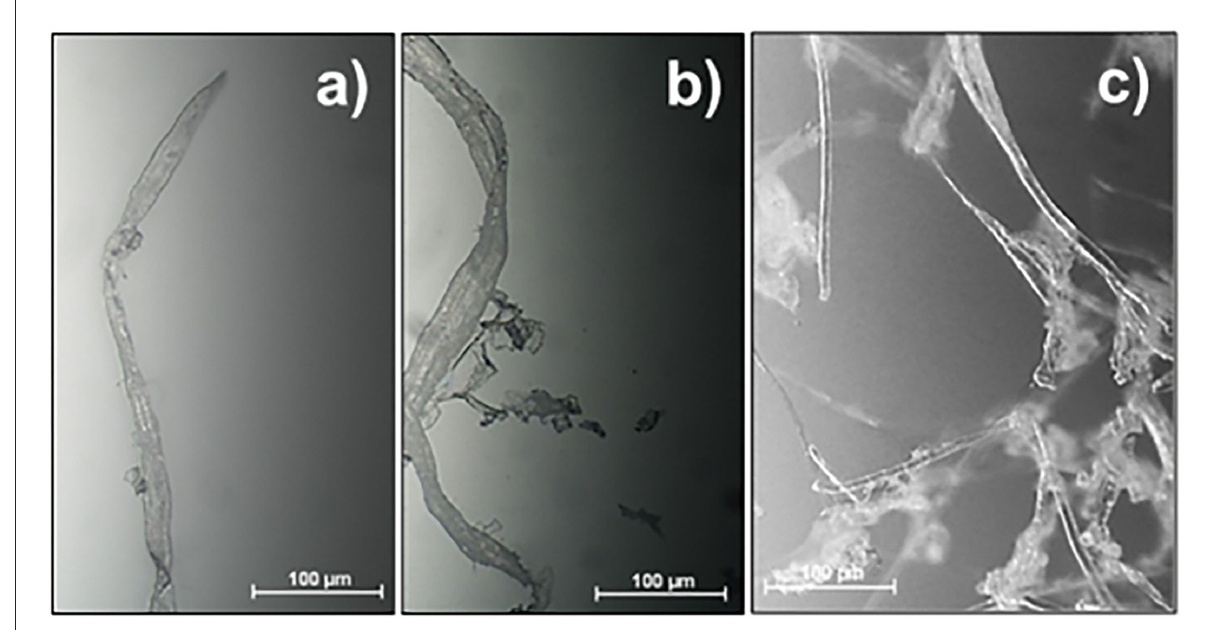
FIGURE5 Optical microscope images of corncob (a) , giant cane cut-up (b) , and garlic stalk (c) , at 10 ×